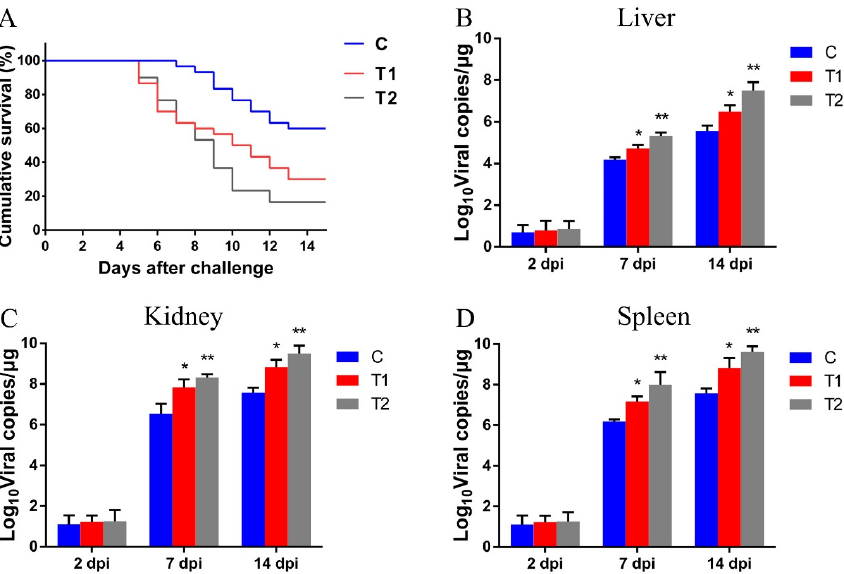
Figure 8. Effects of AFB1 on cyprinid herpesvirus 2 (CyHV-2) infection in gibel carp and viral load in tissues of gibel carp. ( A ) Cumulative survivorship curves of gibel carp intraperitoneally injected with CyHV-2 in different treatment groups. ( B – D ) CyHV-2 viral load in the liver, kidney, and spleen of gibel carp in different treatment groups at 2, 7, and 14 days post infection (dpi). C: control diet, T1: 50 µ g/kg AFB1, T2: 100 µ g/kg AFB1. Data are presented as mean ± standard deviation (SD; * p < 0.05; ** p <